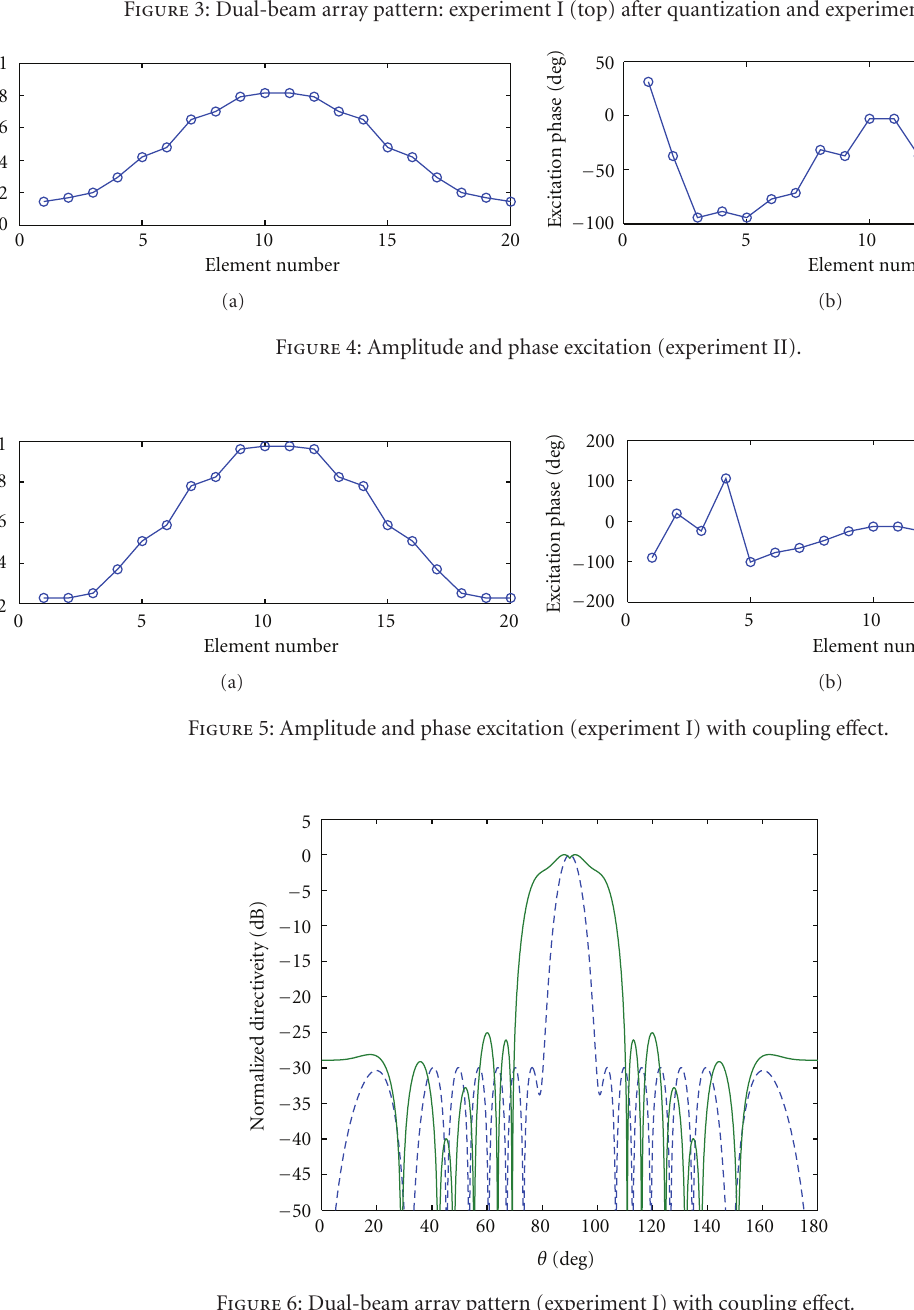
Figure 3: Dual-beam array pattern: experiment I (top) after quantization and experiment II.